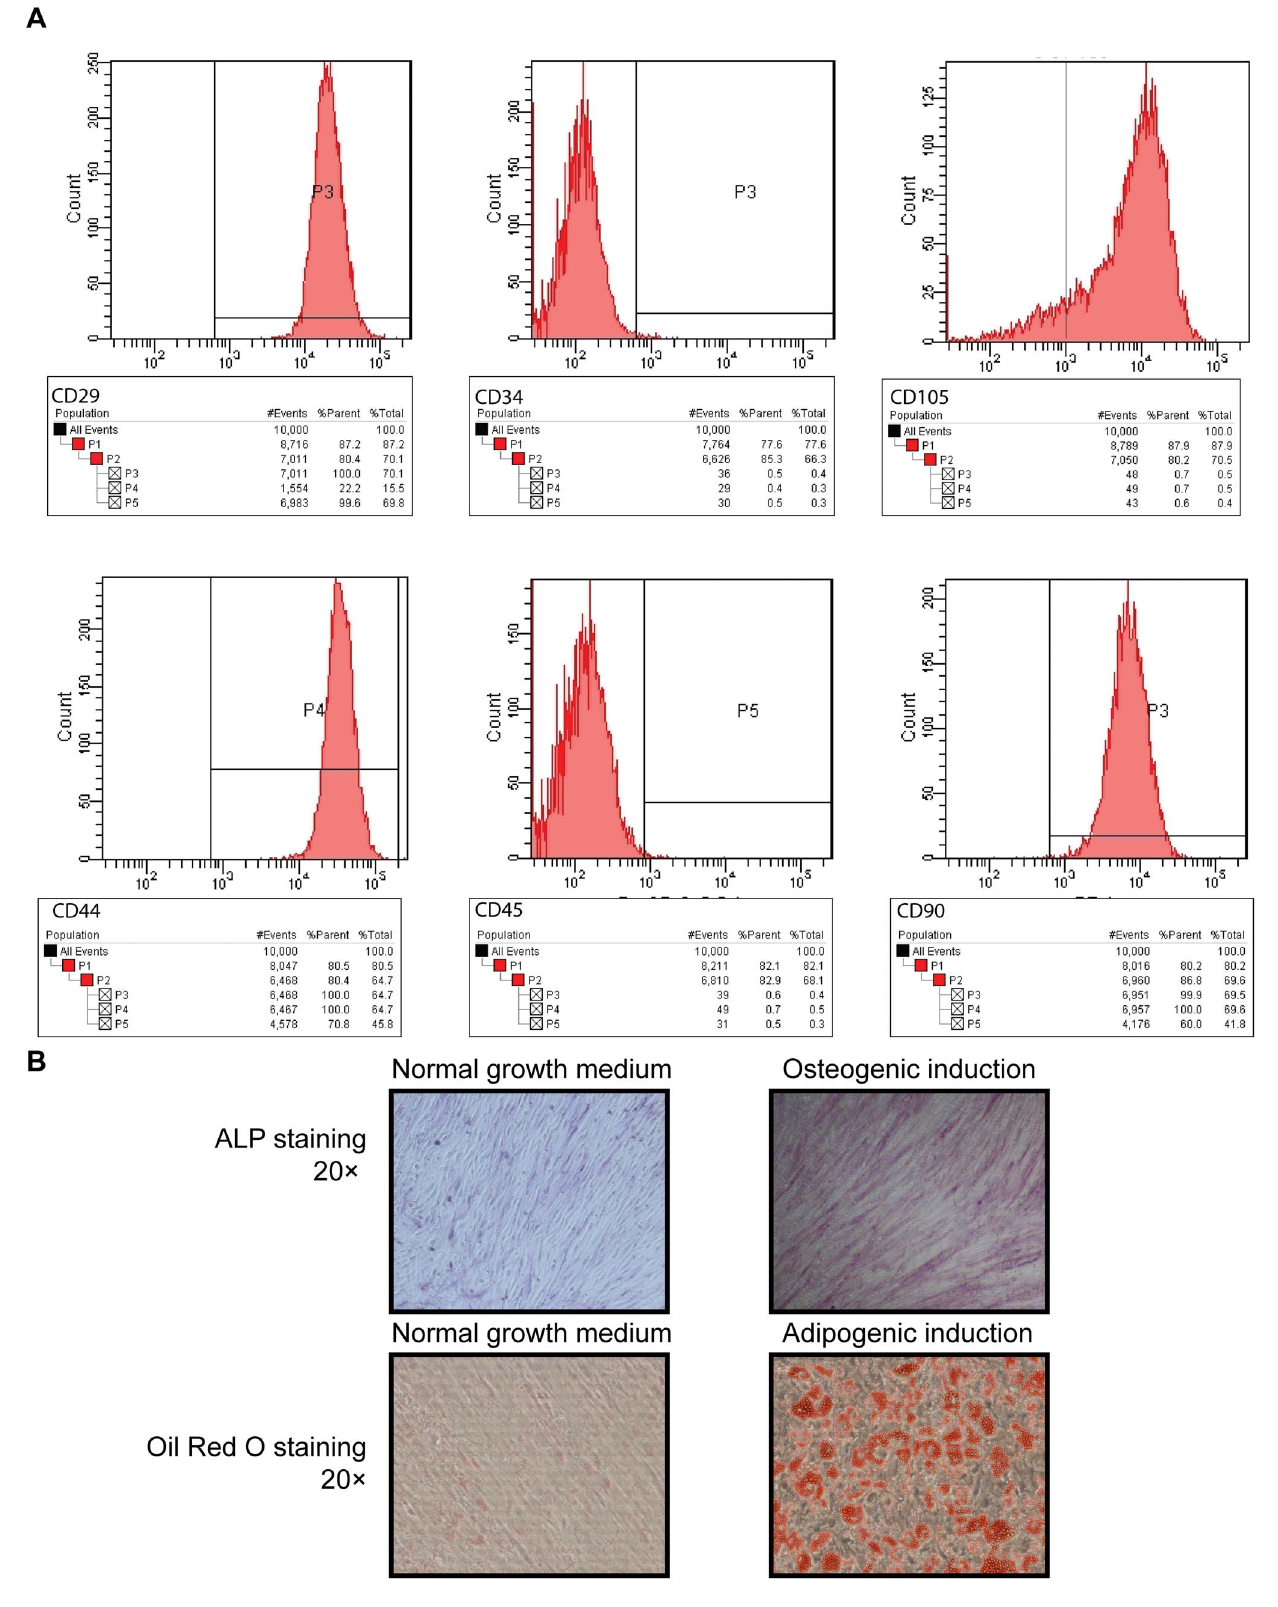
Figure 1. Identification and lineage differentiation potential of hBMSCs. ( A ) hBMSC identification with the surface markers CD29 + , CD34 2 , CD105 + , CD44 + , CD45 2 , and CD90 + . ( B ) The hBMSC lineage differentiation: osteoblasts (ALP stain), and adipocytes (Oil Red O stain).